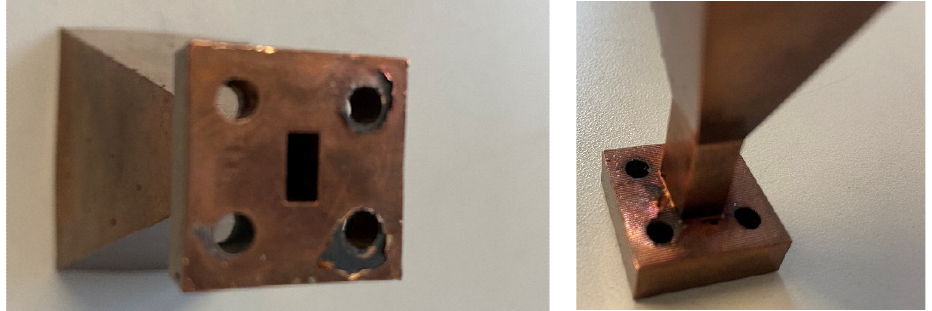
Figure 10. Initial prototypes manufactured in a commercial 3D printer and metallized with a copper coating.